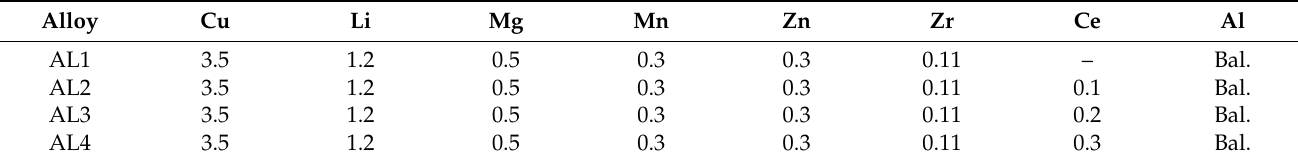
Table 1. Chemical composition of experimental alloys